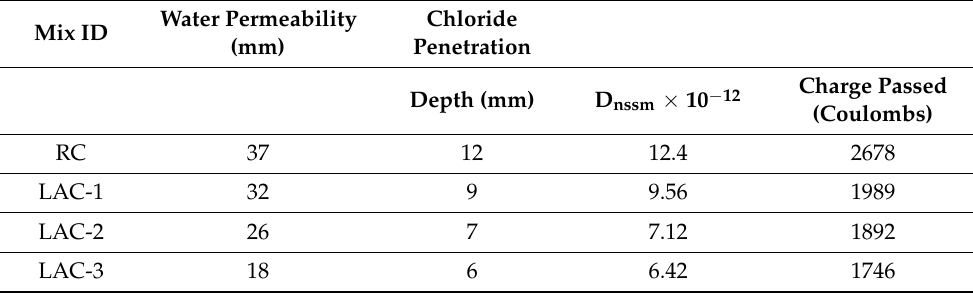
Table 3. Water permeability and chloride penetrability test.